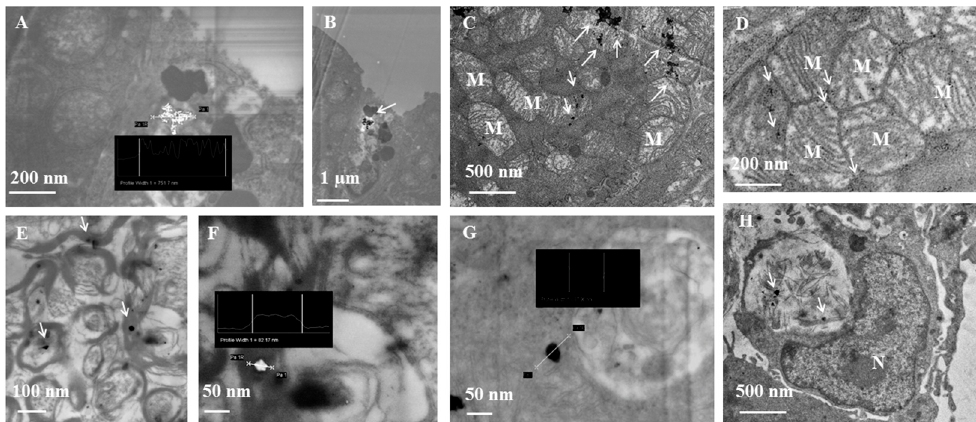
Figure 2. Biodistribution of AgNP-G in a murine model after injection of 10 8 NPs into tail vein. Transmission electron microscopy micrographs of ultrathin sections of mouse organs. White arrows indicate AgNPs as single NPs or as cluster. N: nucleus; GC: goblet cell; RBC: red blood cell; ( A ) intestine; ( B ) kidney; ( C ) brain; ( D ) red blood cell in kidney; ( E ) endothelial cell.